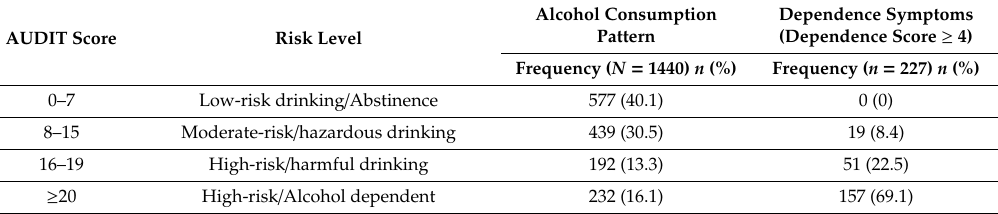
Table 2. Alcohol consumption patterns and dependence symptoms among